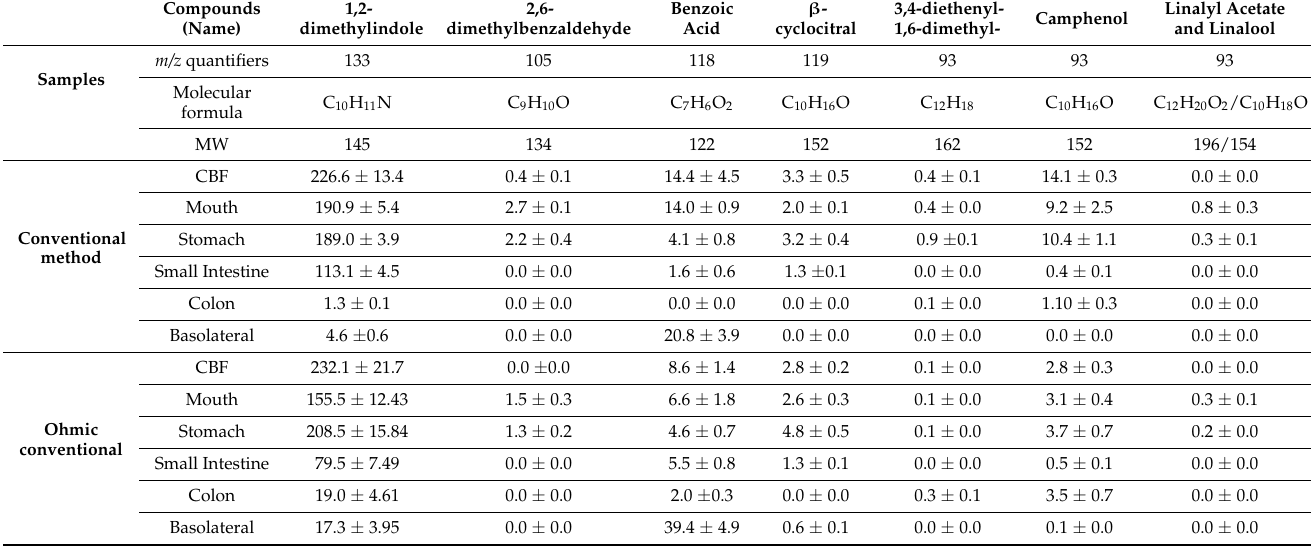
Table 5. Volatile compounds analysis by